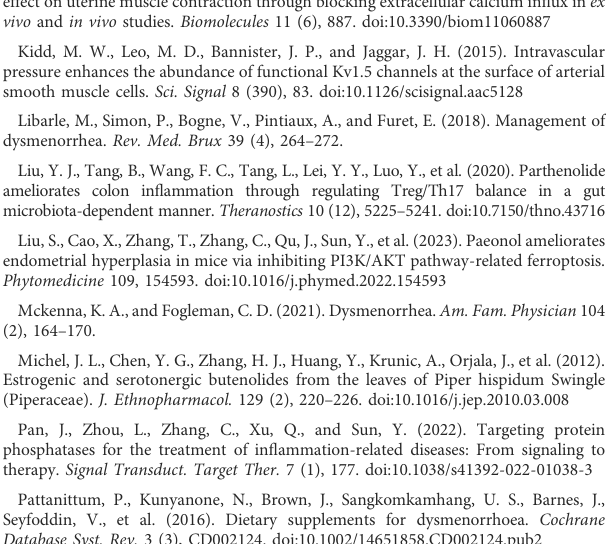
Figdraw (https://www. fi gdraw.com.) for providing the vector graphics material and Editage (www.editage.cn) for English language